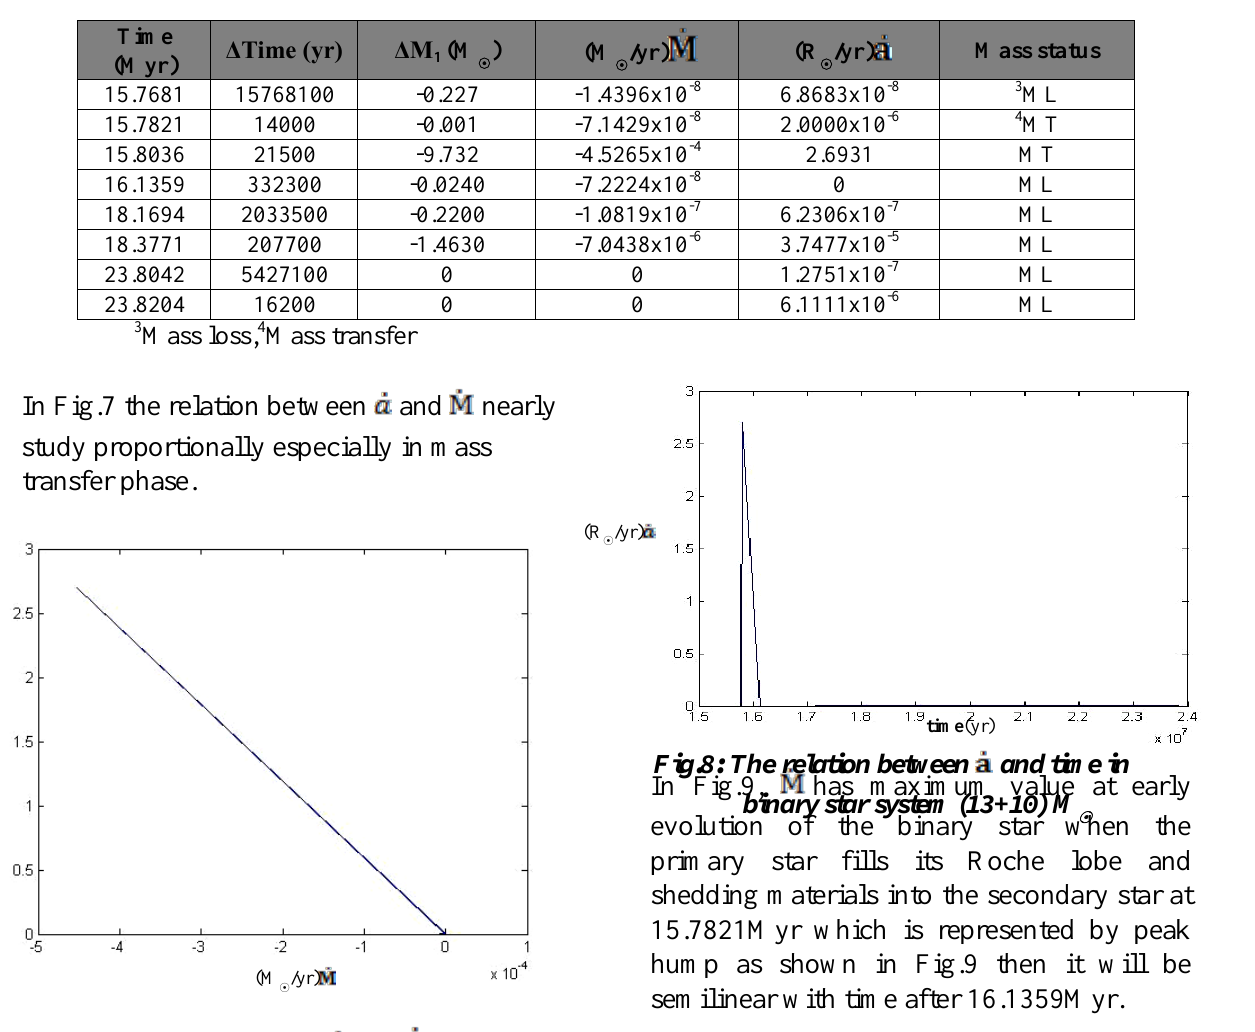
Fig.7: The relation between and in binary star system(13+10)M